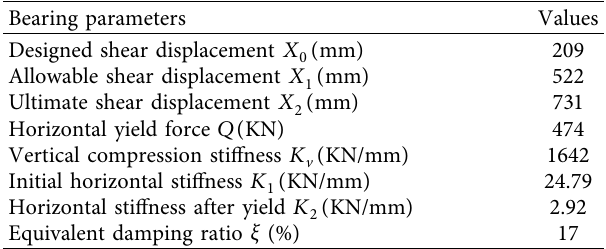
Table 2: Parameters of